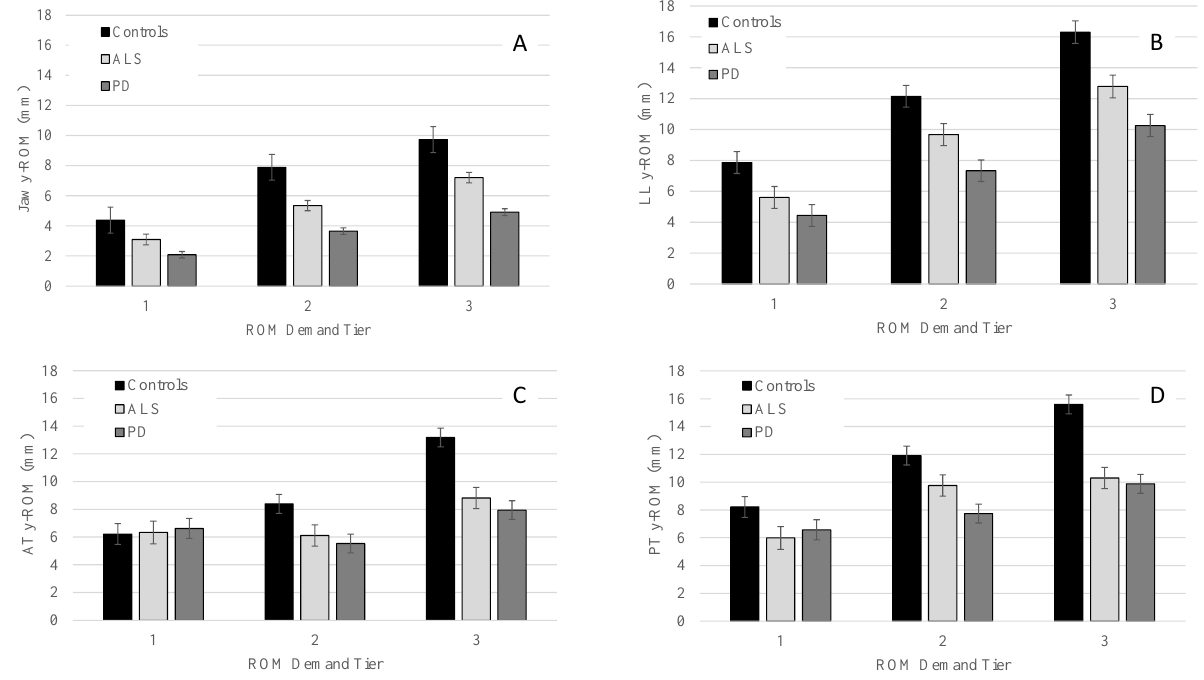
Figure 1. Group means (+/ − SE) for y-ROM of the jaw (Panel ( A )), lower lip (Panel ( B )), anterior tongue (Panel ( C )), and posterior tongue (Panel ( D )) across all ROM demand tiers. Pairwise comparisons for J and LL revealed that the PD group had significantly